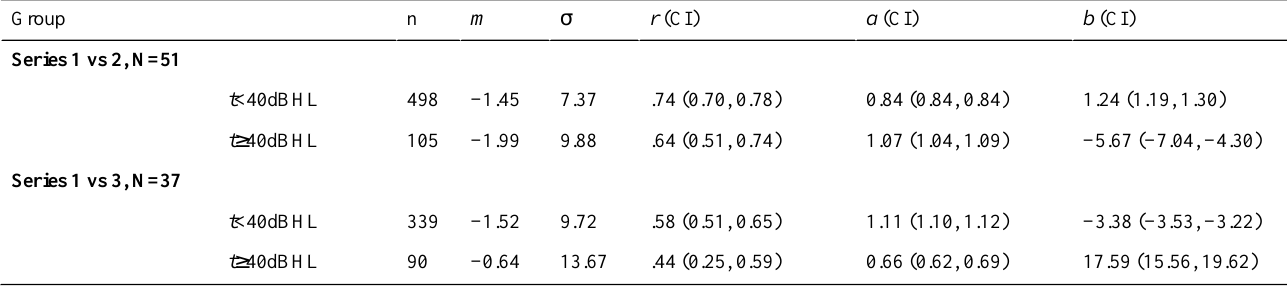
Table 2. The mean difference m in the hearing threshold t between the series calculated on the basis of n data points collected on a group of N subjects, its standard deviation σ , Pearson’s correlation coefficient r and linear estimators a , b of Deming’s regression y = ax + b and corresponding confidence intervals CI at P =.05 for the hearing threshold below 40dBHL as well as greater than or equal to